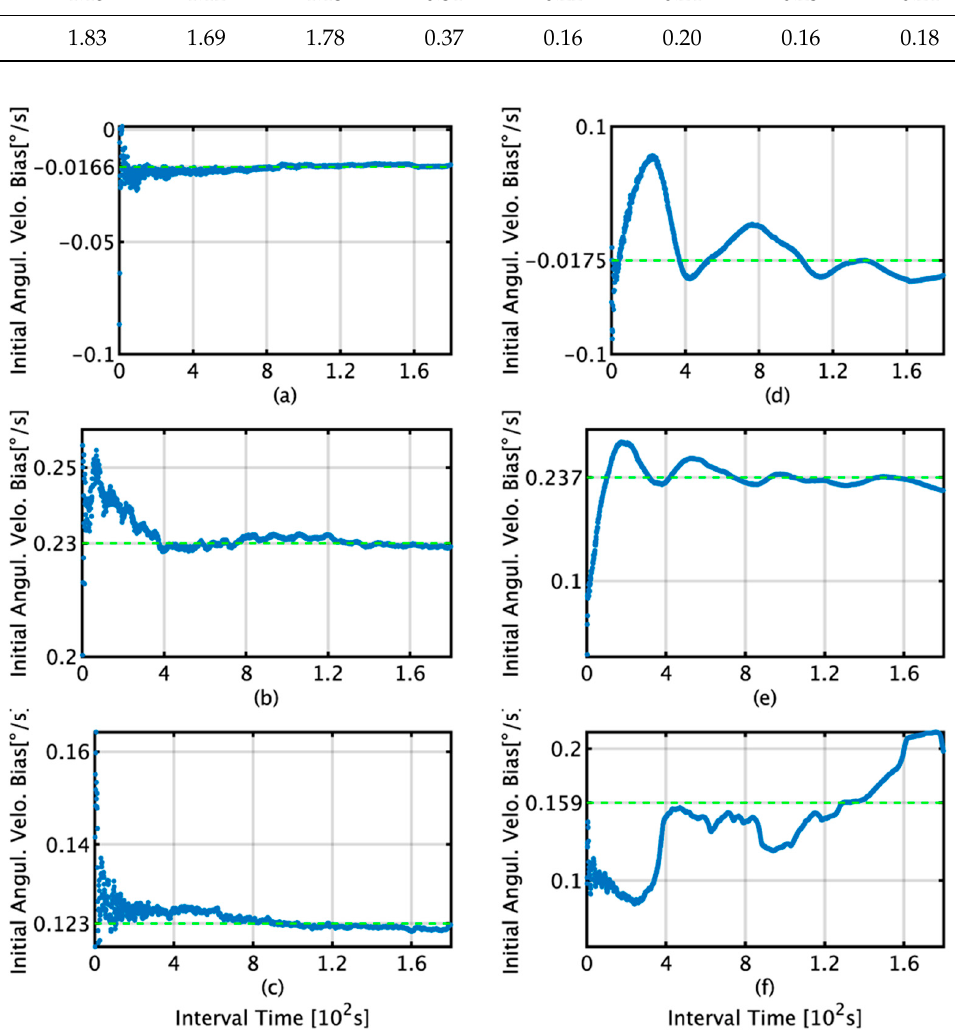
Table 4. Maximum and minimum differences in the RMS roll and pitch when using the initial bias estimates from the TG and KF for INS/DVL. Roll by ISN/DVL ( ◦ ) Pitch by INS/DVL ( ◦ ) Total Over 400 s Total Over 400 s Max.